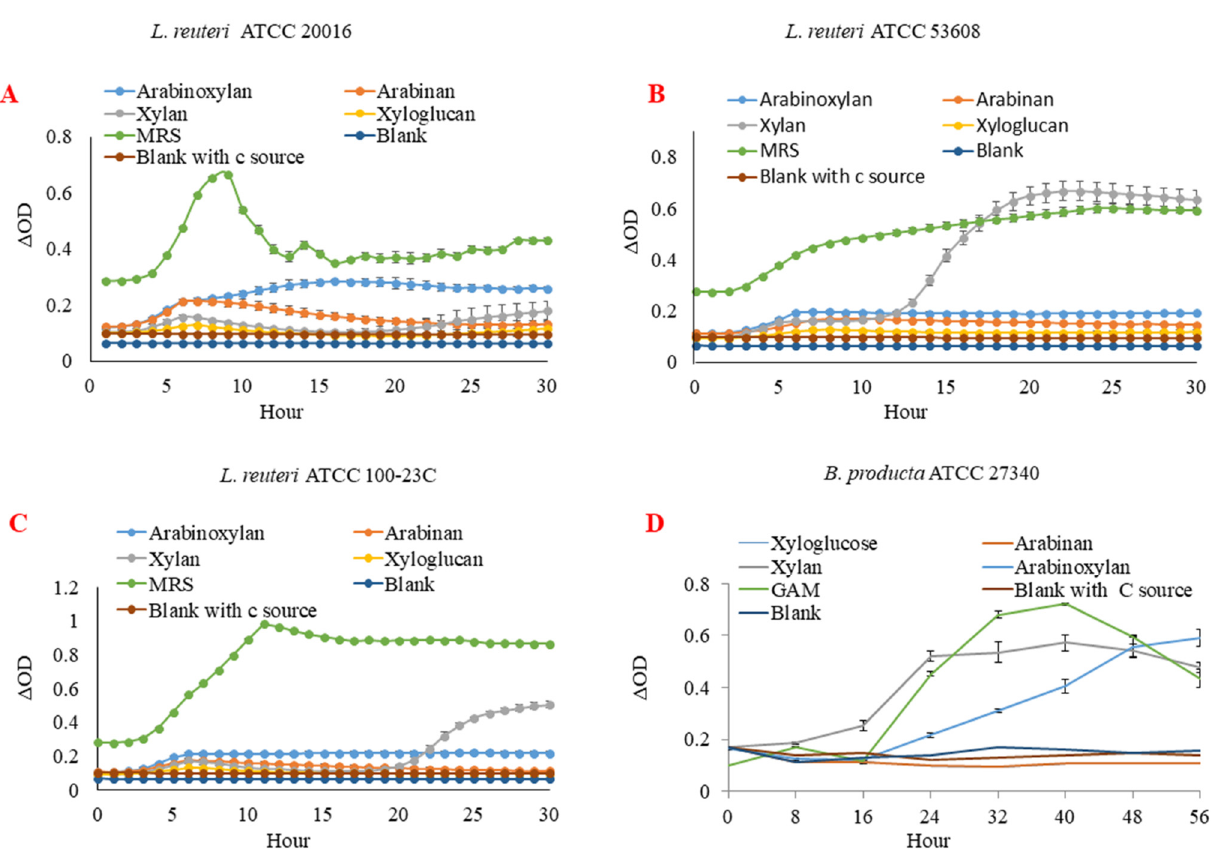
Figure 1. Growth curves of L. reuteri and B. producta strains on different carbon sources. L. reuteri strains ATCC 20016 ( A ), ATCC 53608 ( B ), ATCC 100-23C ( C ), and B. producta ATCC 27340 ( D ) were grown on arabinan, arabinoxylan, xylan (xylooligosaccharides), and xyloglucan. Blank—minimal medium with bacterium inoculated but no additional carbon source. Blank with c source—minimal medium with xylan as a main carbon source. MRS - de Man, Rogosa, and Sharpe medium. GAM- Gifu anaerobic medium.